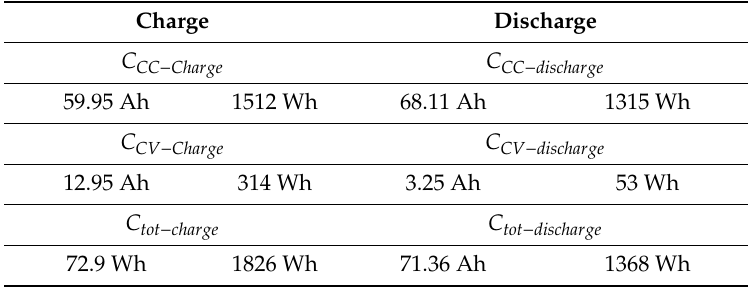
Table 2. Capacity test